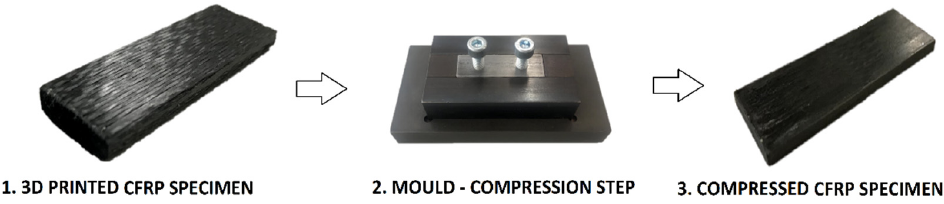
Figure 3. Manufacturing steps of CFRP specimens used to optimize post